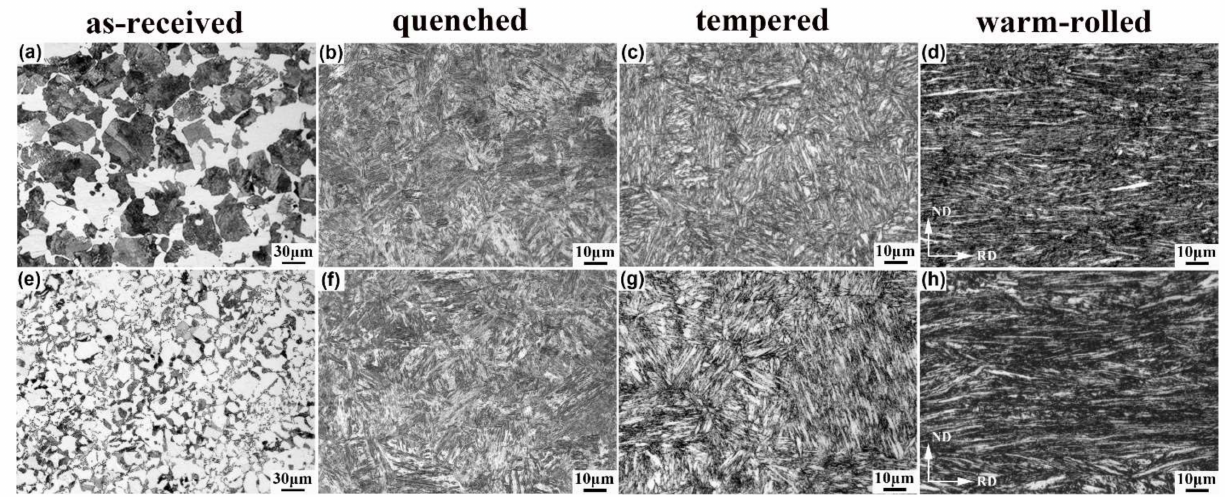
Figure 3. Metallographic microstructures of the ( a – d ) 0.33C and ( e – h ) 0.21C steels in different states. ( a , e ) Annealed; ( b , f ) quenched; ( c , g ) tempered; ( d , h )